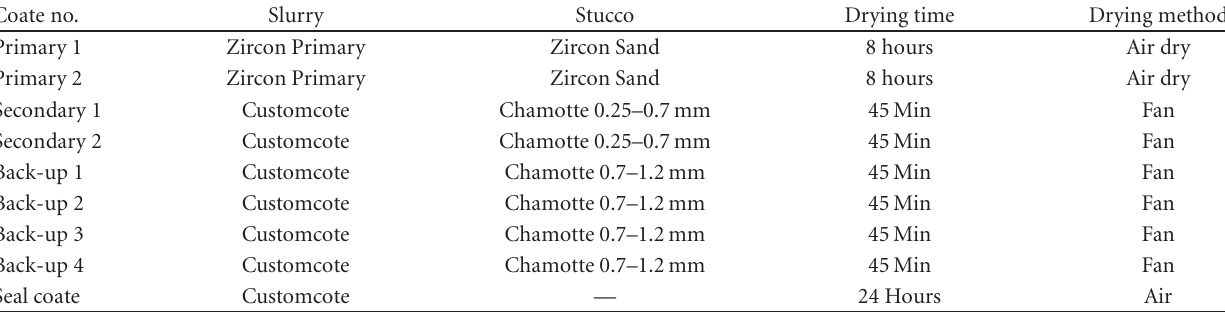
Table 2: The dipping procedure for investment casting of alloy